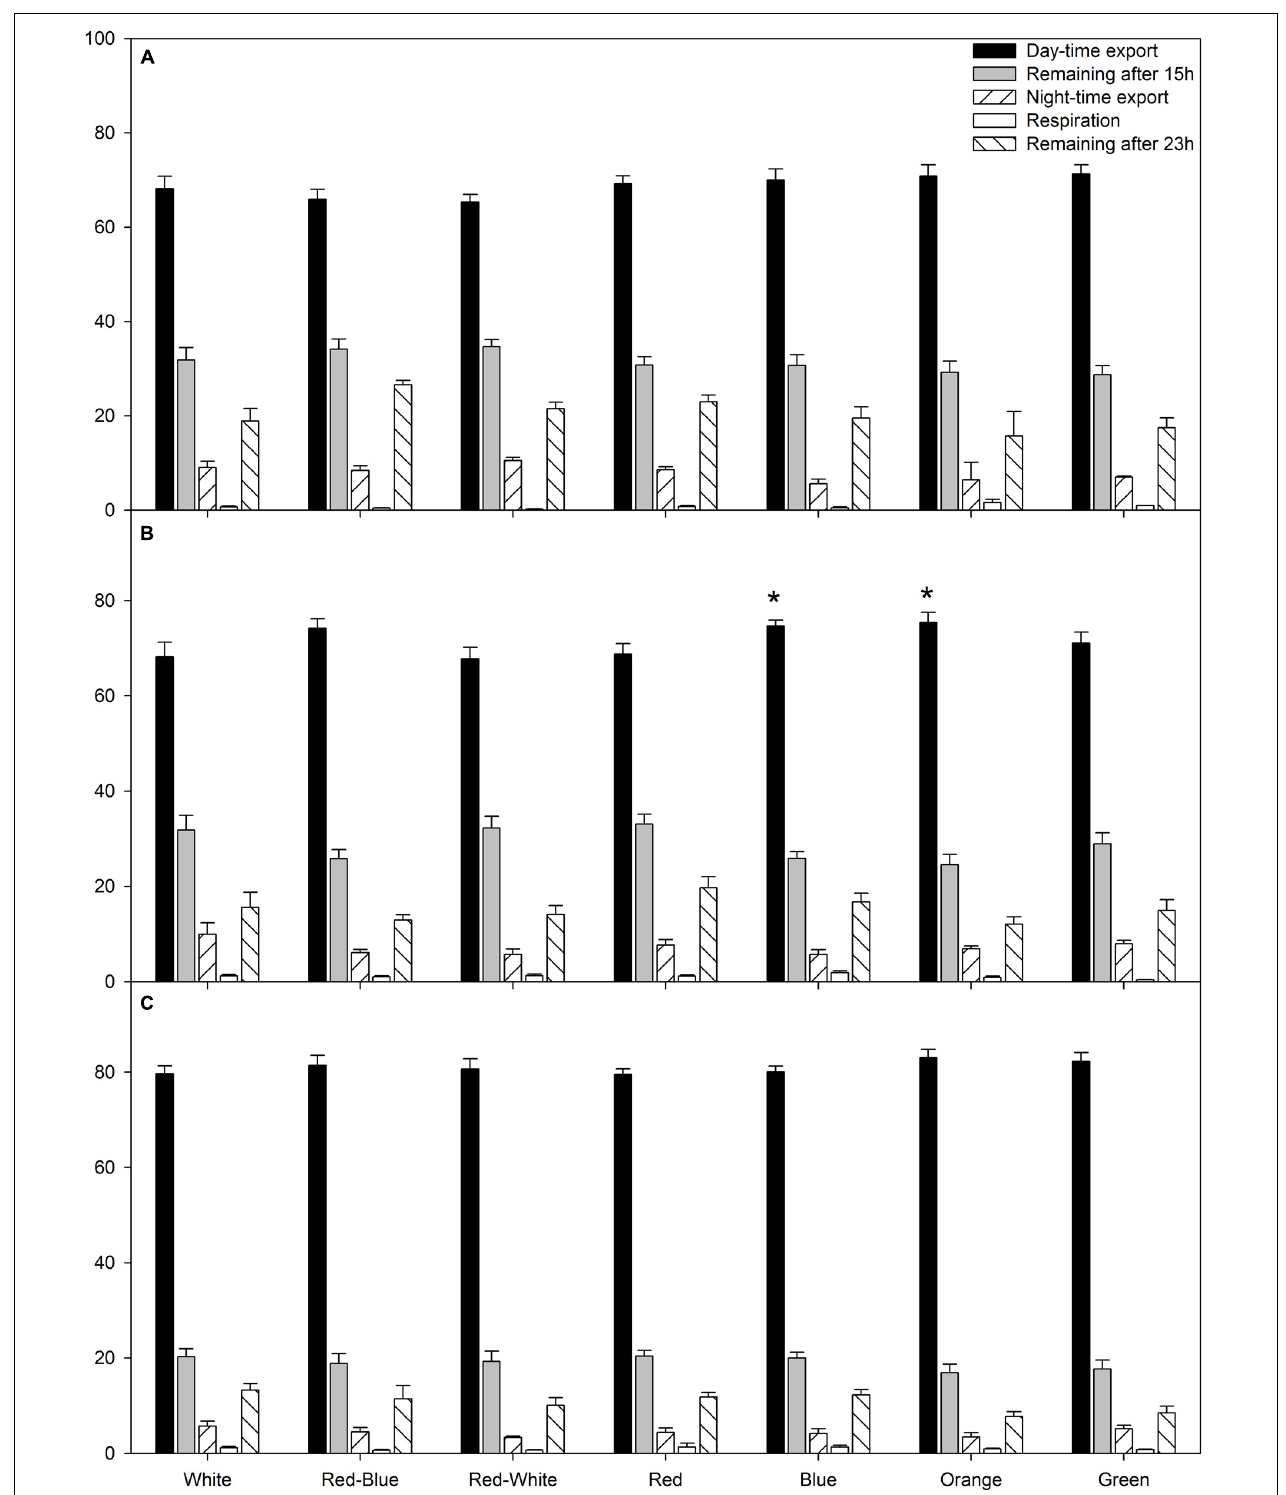
FIGURE 4 | A summary of carbon allocation at high (A) , medium (B) , and low (C) photosynthetic rates to day-time export, storage in the leaf at the end of the photoperiod, night-time export, night-time respiration, and storage in the leaf after 23 h pulse and chase experiment. Carbon allocation is expressed as a percentage of total carbon fixed during the photoperiod. A statistical difference ( p < 0.05) in the percentage of day-time export between an LED treatment and the W LED control is indicated with an asterisk ( ∗ ).